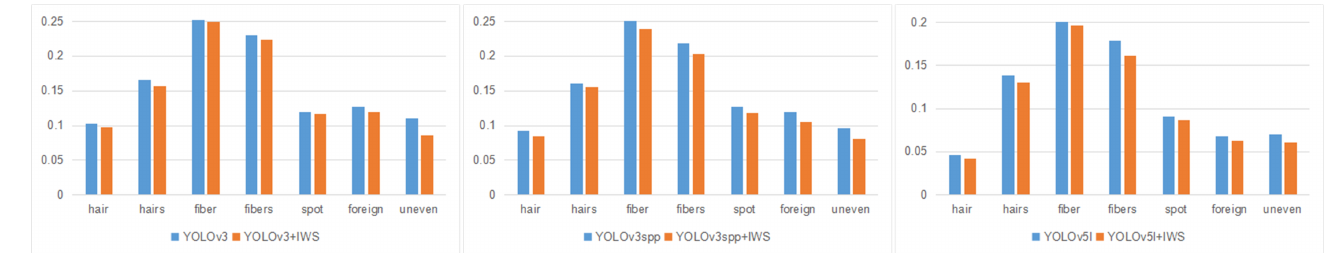
Figure 11. Visualization of the false detection rate of the same class as different